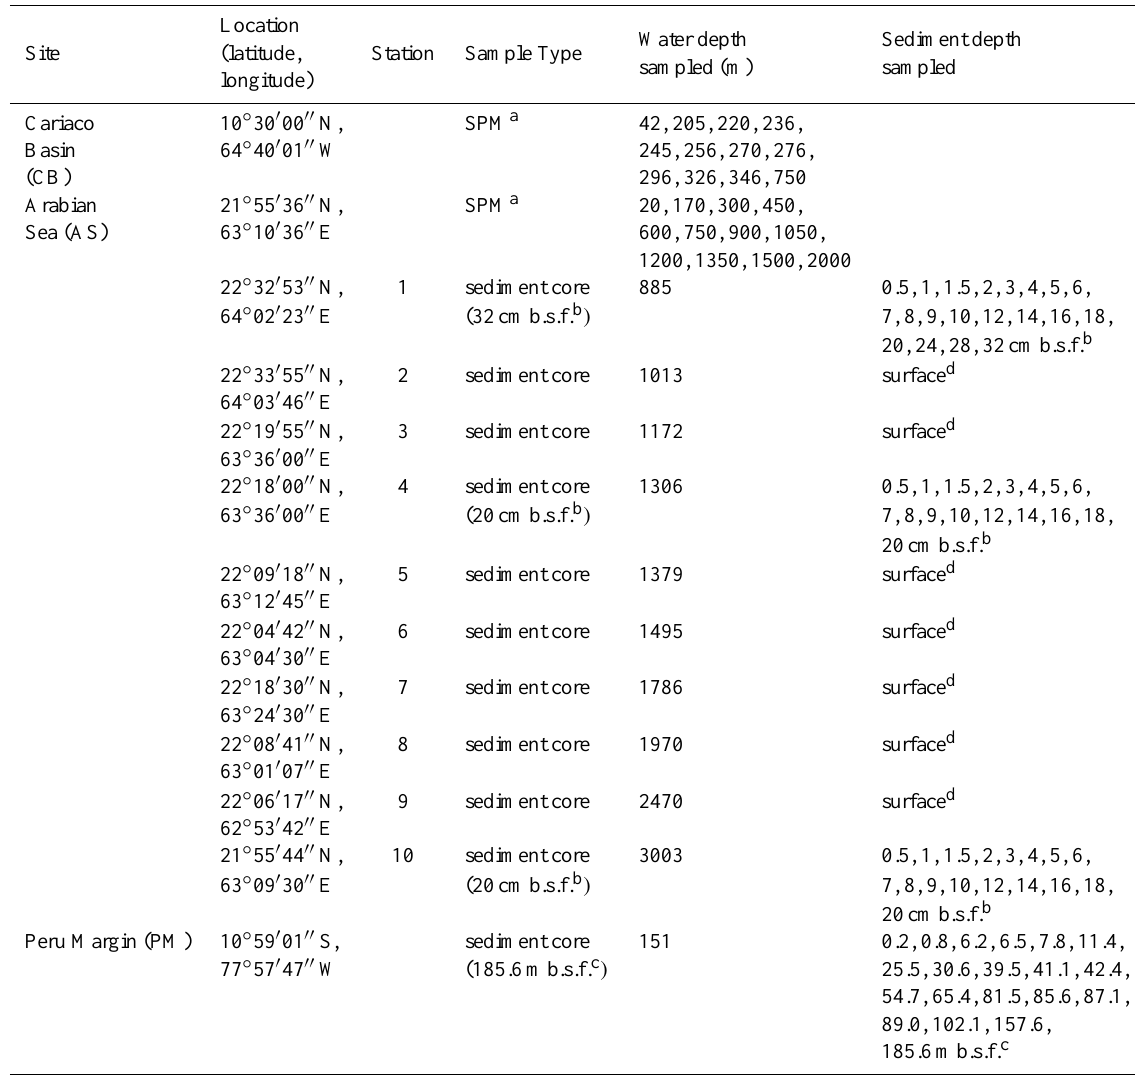
Table 1. Location, type, and water depth of samples used in this study.